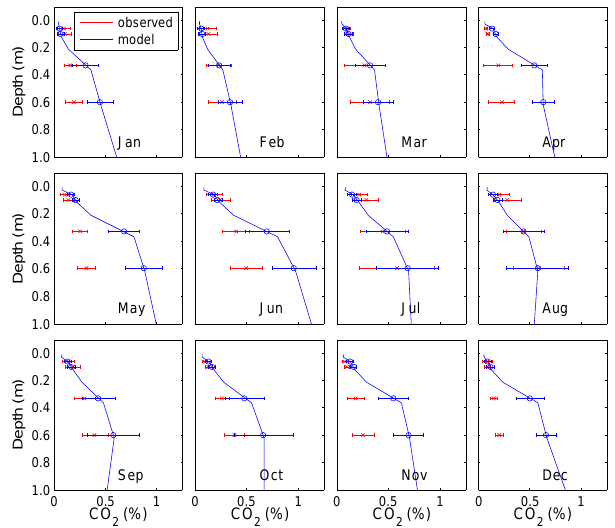
Fig. 6. Comparison between measured and simulated soil CO 2 pro- files for a whole seasonal cycle. Both the measurement and model simulation were aggregated monthly for the comparison. The error bar indicates the one-sigma standard deviation derived from all the data points in a given